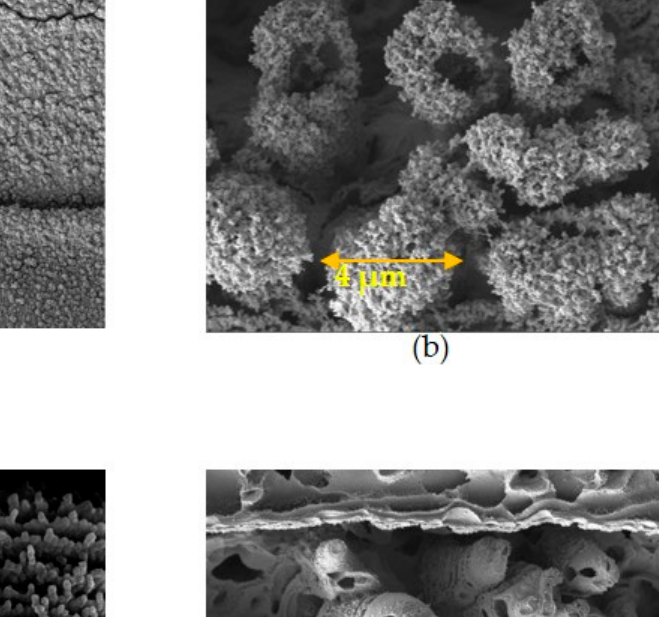
Figure 5. The graphene-like flake structure of the LIG pattern; ( a ) SEM image of the graphene-like flake structure of LIG; ( b ) Raman spectra of the LIG pattern irradiated laser with different laser fluences.